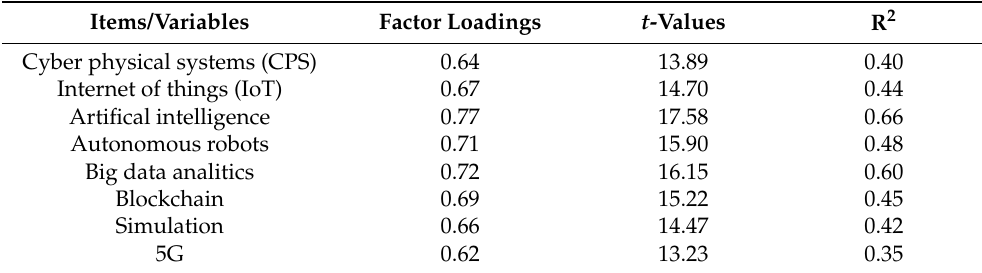
Table 13. Factor Loading, t -values and R 2 for